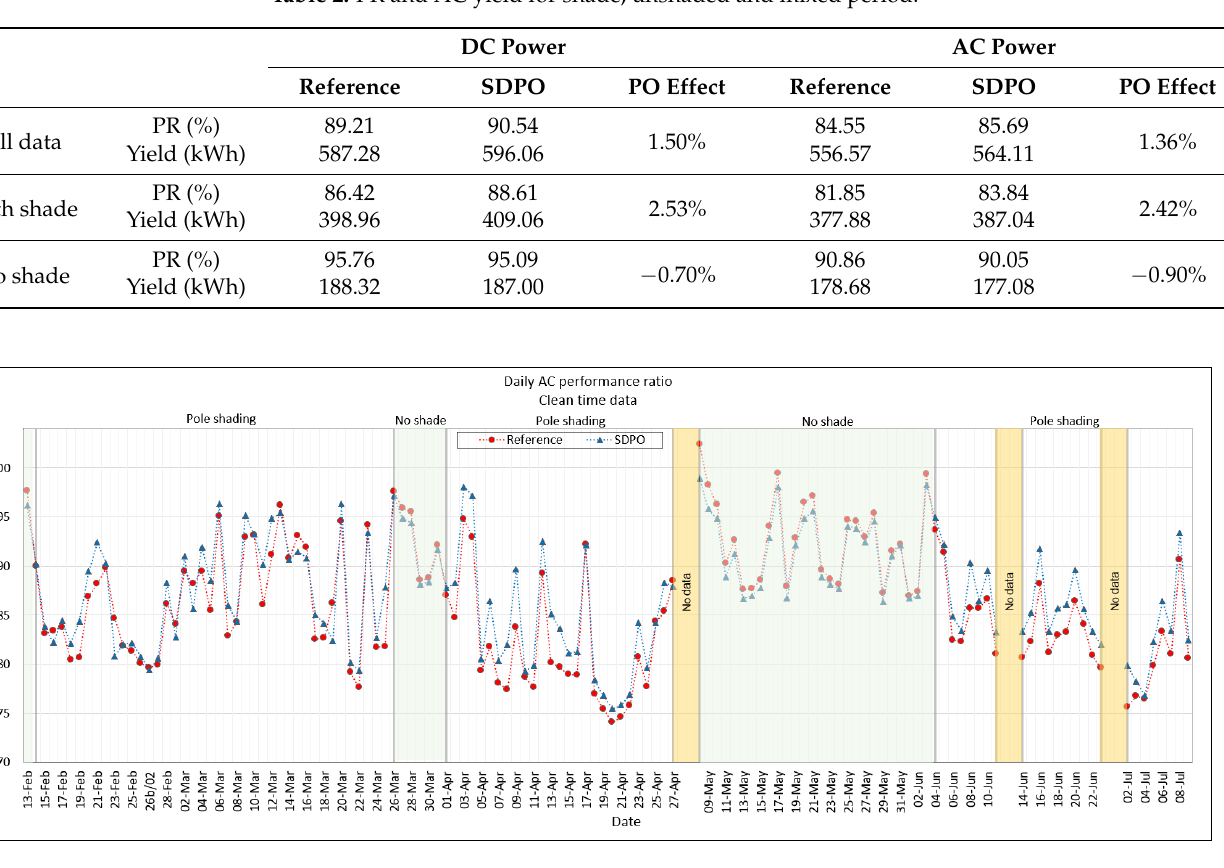
Figure 11. Daily PR of the systems for 6 months.